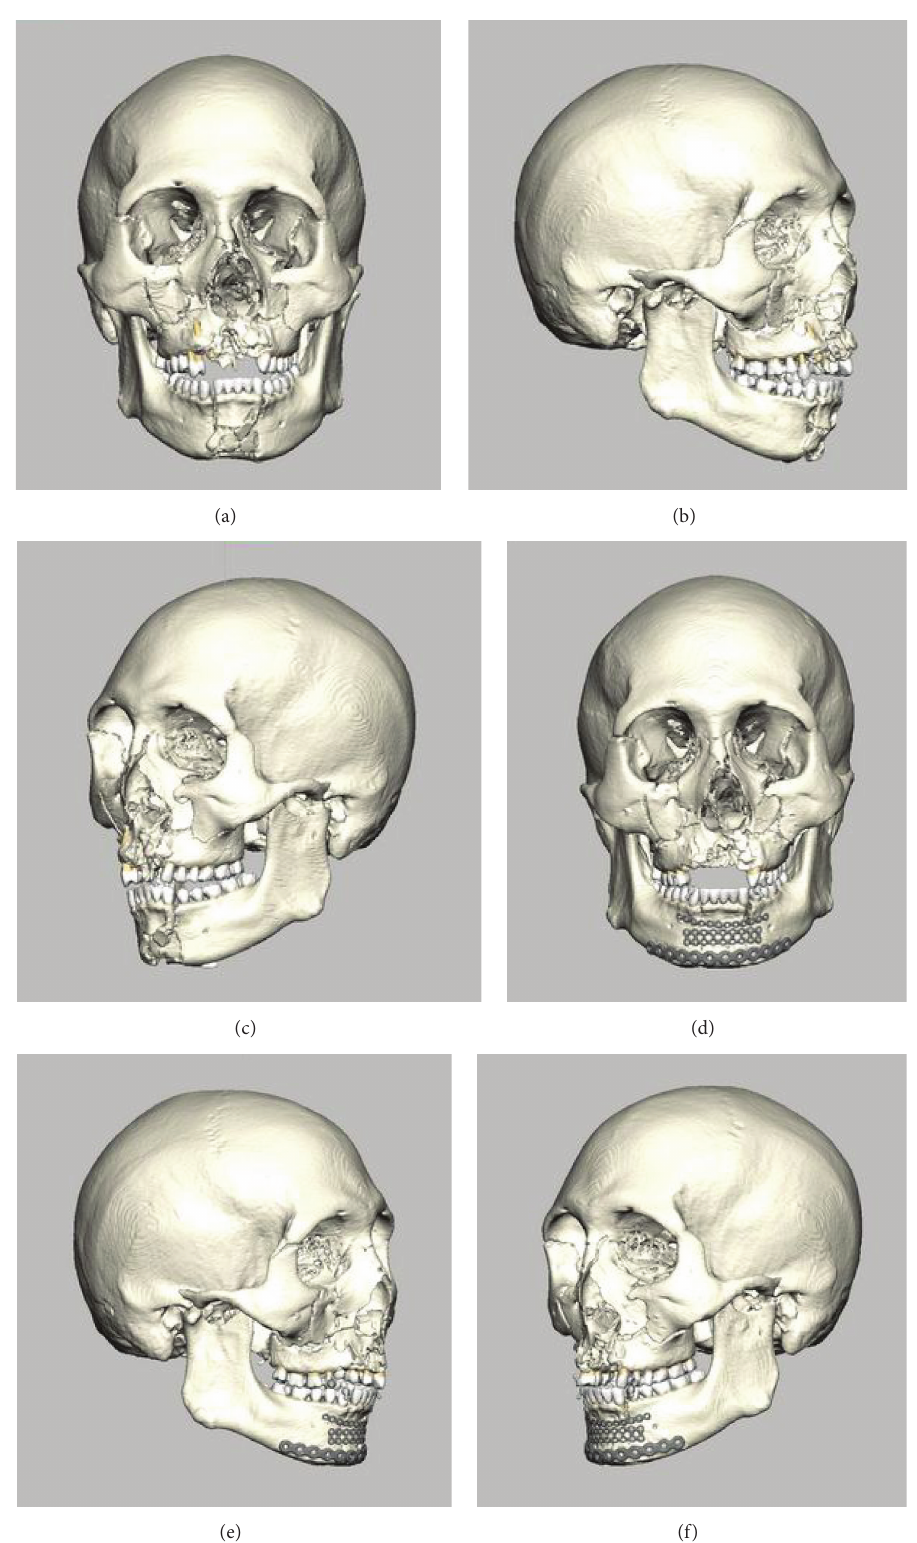
Figure 1: Images from preoperative and postoperative 3D-CT. (a)–(c) showed that bilateral condylar and mandibular fractures, LeFort II- type fracture, and blow-out fracture of orbit are apparent. (d)–(f) showed that mandibular fracture was fixed by titanium plates and LeFort II-type fracture and blow-out fracture of the orbit were fixed by absorbable plates. (a) Preoperative frontal view. (b) Preoperative lateral view of the right. (c) Preoperative lateral view of the left. (d) Postoperative frontal view. (e) Postoperative lateral view of the right. (f) Postoperative lateral view of the